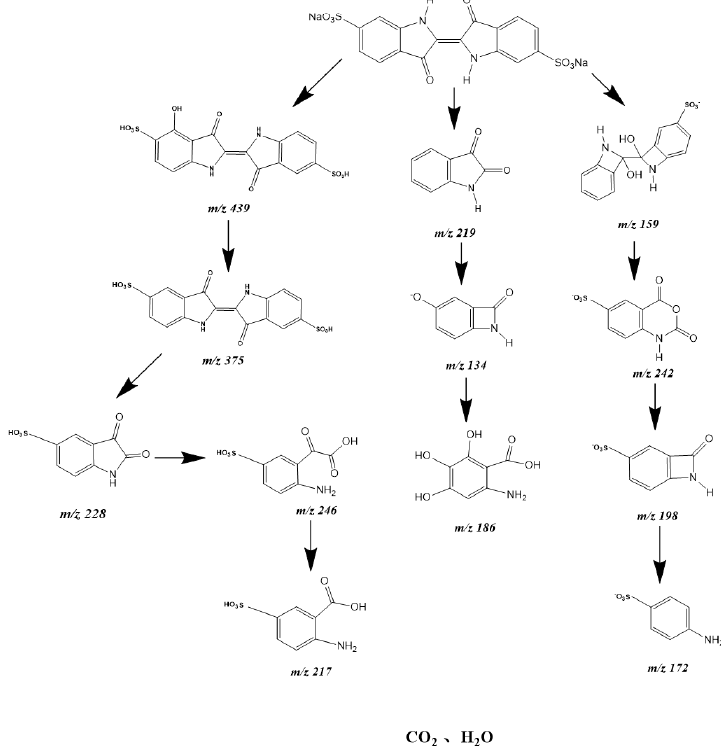
Figure 25. Possible PCD pathway scheme for IC under VLGI with IBHP.